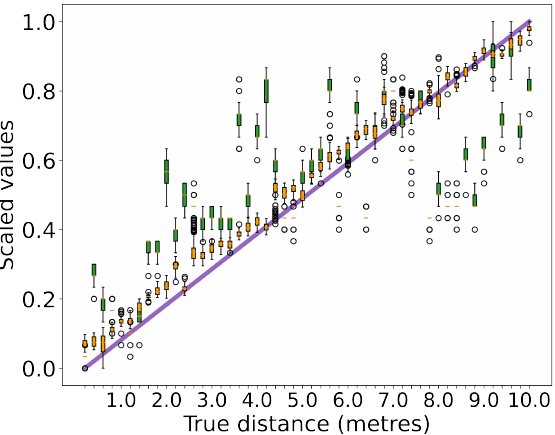
Figure 13. The comparison of WiFi RSS and RTT measurements as a function of the true distance in a long narrow corridor. The WiFi signal suffered from severe reflections and attenuations. The RSS (as shown in green color) and RTT (as shown in orange color) values were normalized. We observed that in complex indoor spaces, the RSS produced large variance even with clear LOS path to the AP. The RSS measurements were unpredictable with similar values up to 9 m away. In contrast, the RTT measures were more stable and had a clear positive correlation to the true distance.